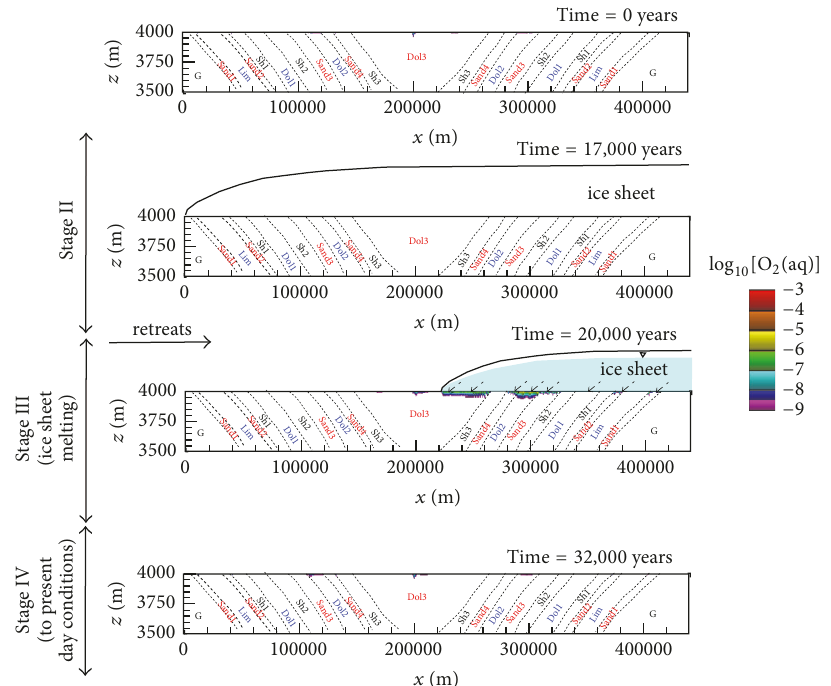
Figure 8: Spatial O 2 (aq) concentration distributions at different times for Scenario 1 with a 10-fold increase of O 2 -consumption rates (i.e., at 0, 17,000, 20,000, and 32,000 years), corresponding to the initial condition, the end of Stage II, Stage III, and the final condition. O 2 concentrations in mol l −1